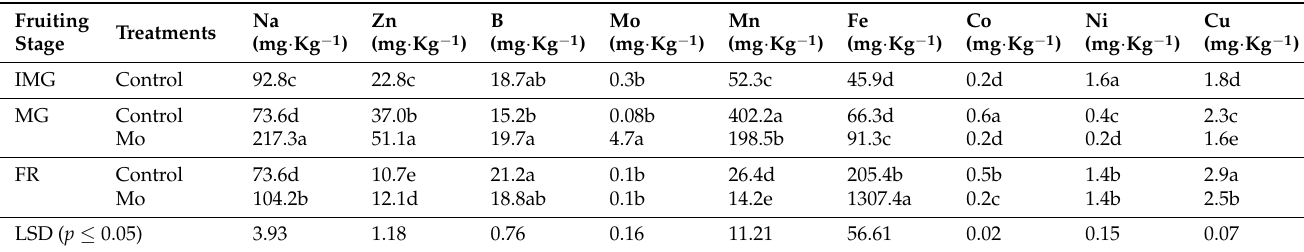
Table 12. Micronutrient concentrations in seeds of loquat as affected by the foliar application of molybdenum. Fruiting Stage